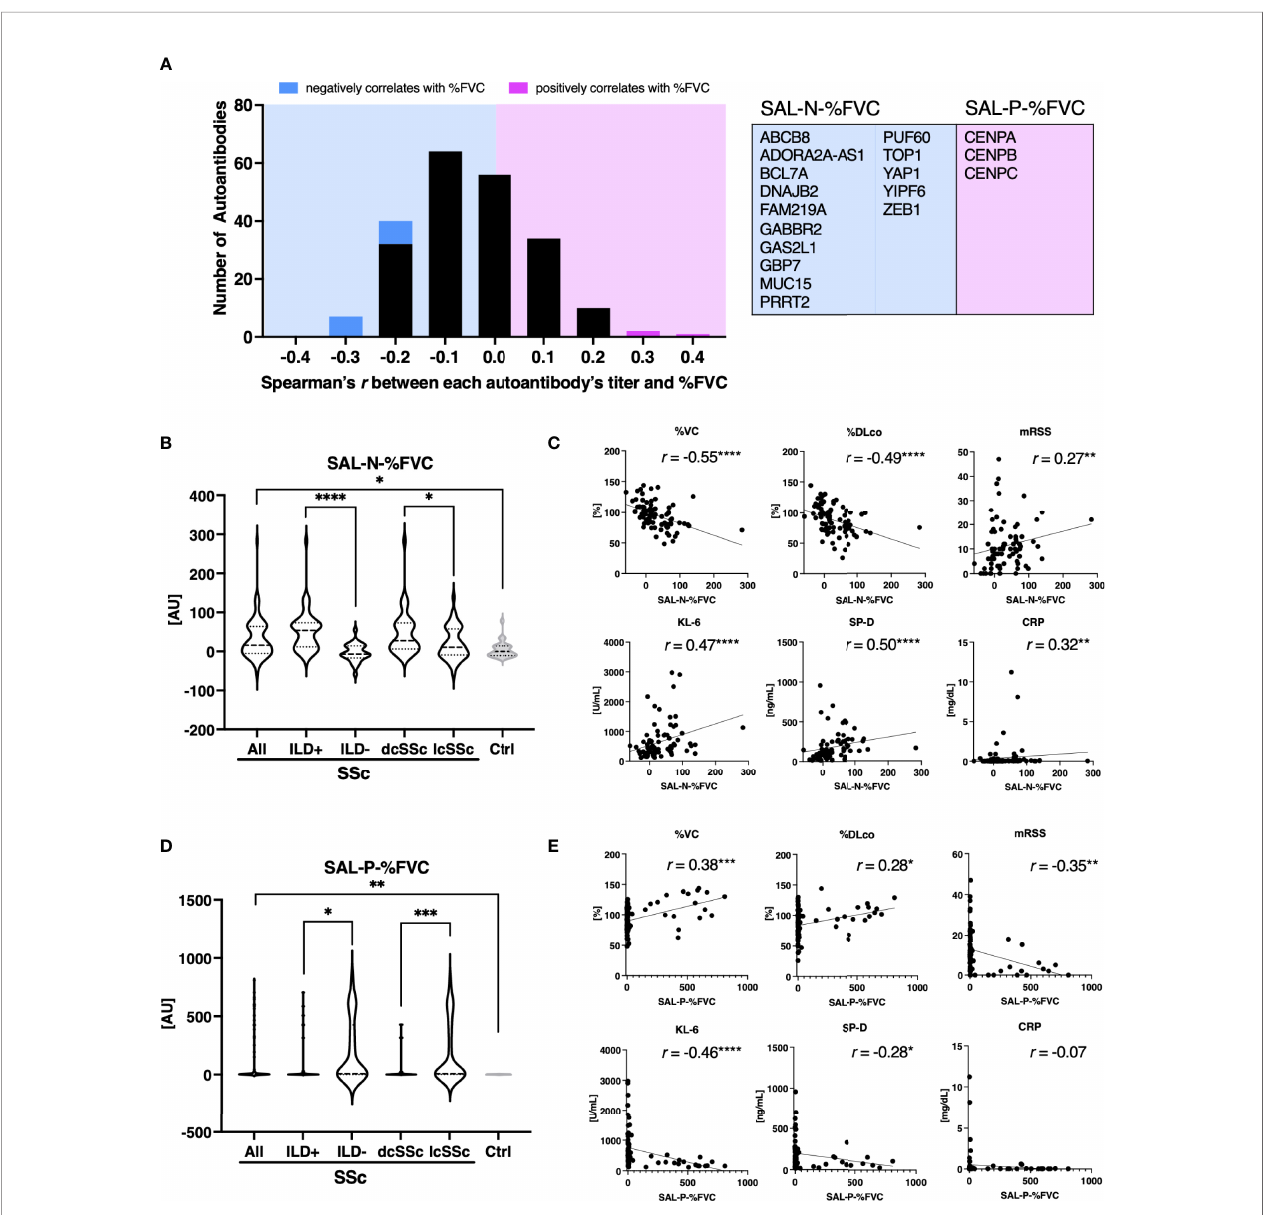
FIGURE 5 | Association between sum of autoantibody levels that correlates with forced lung vital capacity and clinical presentation in patients with systemic sclerosis. (A) Histograms of Spearman ’ s correlation coef fi cient between percentage of predicted forced lung vital capacity (%FVC) and each autoantibody level in individual sera of patients with systemic sclerosis (SSc). Autoantibodies that negatively or positively correlated with %FVC with statistical signi fi cance are highlighted in cyan or in magenta, respectively. Their targets are listed in the table with the gene symbols of their origin. AU, arbitrary unit. (B) Violin plots of sum of autoantibody levels that negatively correlated with %FVC with statistical signi fi cance (SAL-N-%FVC) in SSc patients and healthy controls. Subpopulation analysis revealed that SAL-N-%FVC was signi fi cantly elevated among SSc patients with interstitial lung disease (ILD), or diffuse cutaneous SSc (dcSSc) compared to limited cutaneous SSc (lcSSc). P values were calculated by Mann-Whitney U test. (C) Correlation between SAL-N-%FVC and pulmonary function, serum ILD markers, skin thickness score, and serum CRP levels. r: Spearman ’ s correlation coef fi cient. P values were calculated by estimating r . %DLco: percentage of predicted lung diffusing capacity for carbon monoxide, KL-6: Krebs von den Lungen-6, SP-D: surfactant protein-D, mRSS: modi fi ed Rodnan ’ s total skin thickness score. (D) Violin plots of sum of autoantibody levels that positively correlated with %FVC with statistical signi fi cance (SAL-P-%FVC) in SSc patients and healthy controls. Subpopulation analysis revealed that SAL-P-%FVC was signi fi cantly lower among SSc patients with ILD, or dcSSc compared to lcSSc. P values were calculated by Mann-Whitney U test. (E) Correlation between SAL-P-%FVC and pulmonary function, serum ILD markers, skin thickness score, and serum CRP levels. * P < 0.05, ** P < 0.01, *** P < 0.001, **** P <